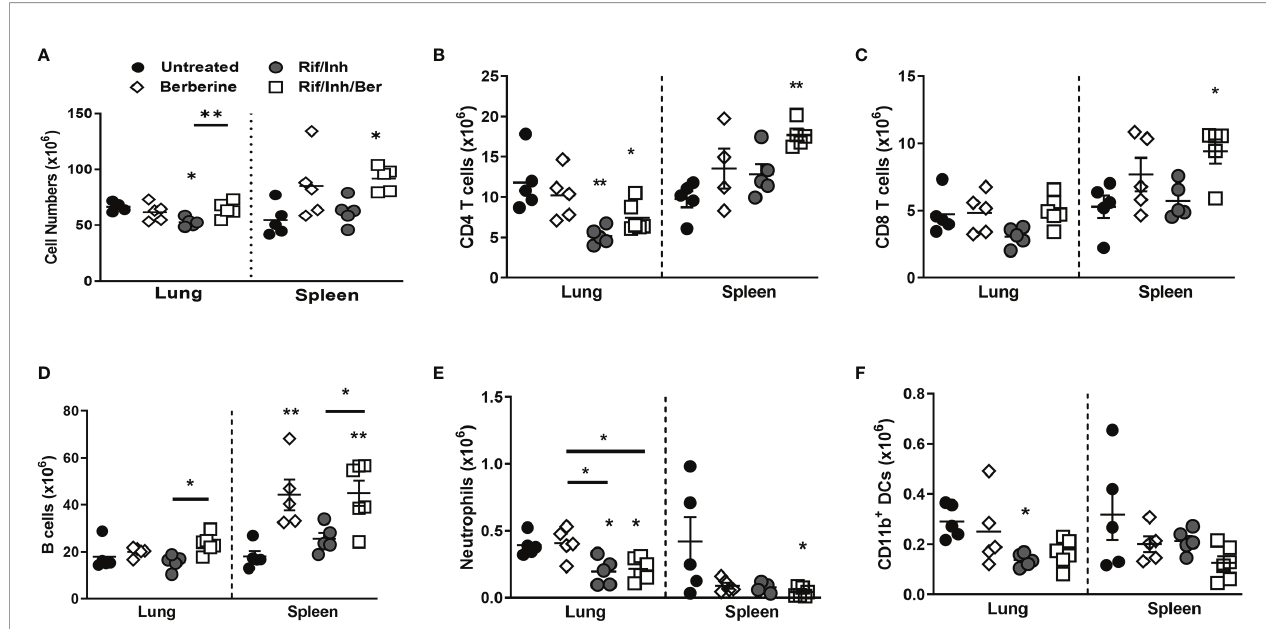
FIGURE 7 | Effect of late-onset berberine adjunctive therapy on lung and spleen immune cell populations during Mtb infection in C57BL/6 mice. Single-cell suspension of lungs and spleens were analyzed for immune cell populations by fl ow cytometry at 4 weeks post-treatment; (A) Total lung and spleen cells, (B) CD4 T cells (CD19 - CD3 + CD4 + CD8 - ), (C) CD8 T cells (CD19 - CD3 + CD8 + CD4 - ), (D) B cells (CD19 + CD3 - ), (E) Neutrophils (CD11b + Ly6G + ), (F) CD11b Dendritic cells counts (CD11c + CD11b + MHCII + ). Data is shown representative of two experiments (n = 5 per group) and the line denotes mean value, analysed by one-way ANOVA with Tukey post-hoc test (A – D) and Kruskal-Wallis test with Dunn ’ s multiple comparisons correction (E, F) de fi ning differences in all groups as signi fi cant *P ≤ 0.05; **P ≤ 0.01. Asterisks without the line below show the signi fi cance compared to the untreated